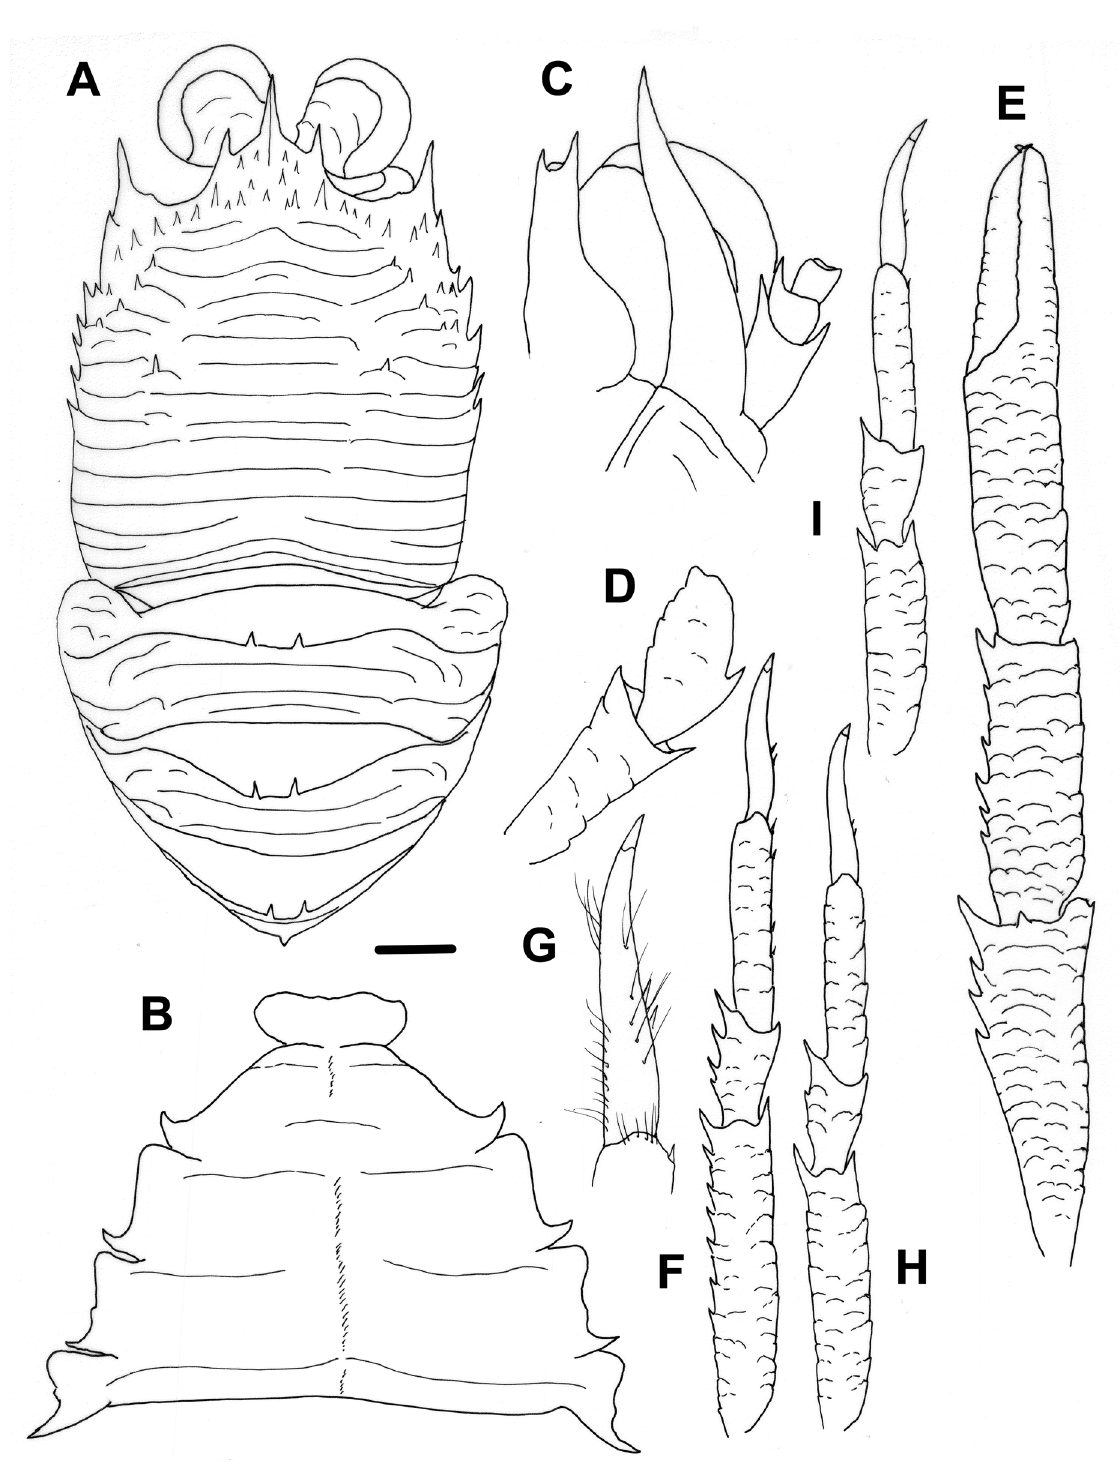
Fig. 4. Torbenella lupi sp. nov., holotype, ov. ♀, CL = 10.2 mm (MNHN-IU-2014-10024), Papua- New Guinea. A . Carapace and abdomen, dorsal view. B . Sternal plastron. C . Cephalic region, showing antennular and antennal peduncles, ventral view. D . Right Mxp3, lateral view. E . Right P1, dorsal view. F . Right P2, lateral view. G . Dactylus of right P2, lateral view. H . Right P3, lateral view. I . Right P4, lateral view. Scale bar: A, E–F, H–I = 2.0 mm; B–D, G = 1.0